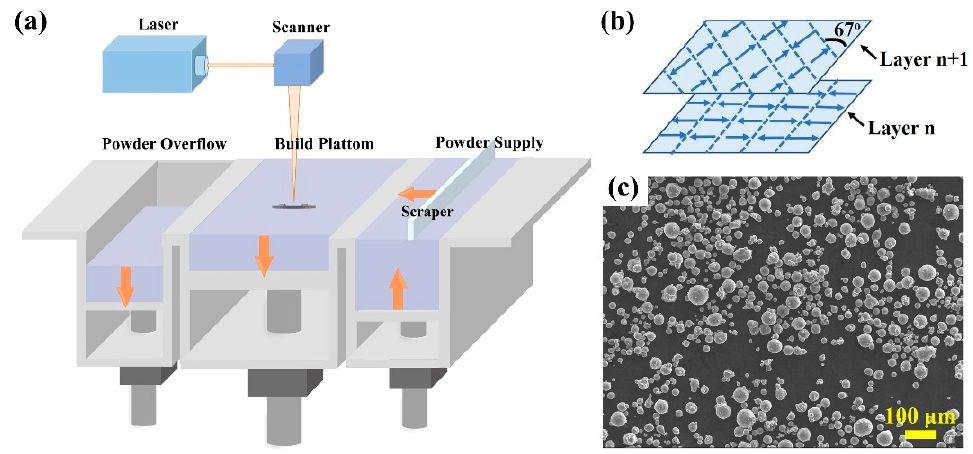
Figure 1. ( a ) Schematic diagram of SLM; ( b ) scanning strategy; ( c ) powder morphology.